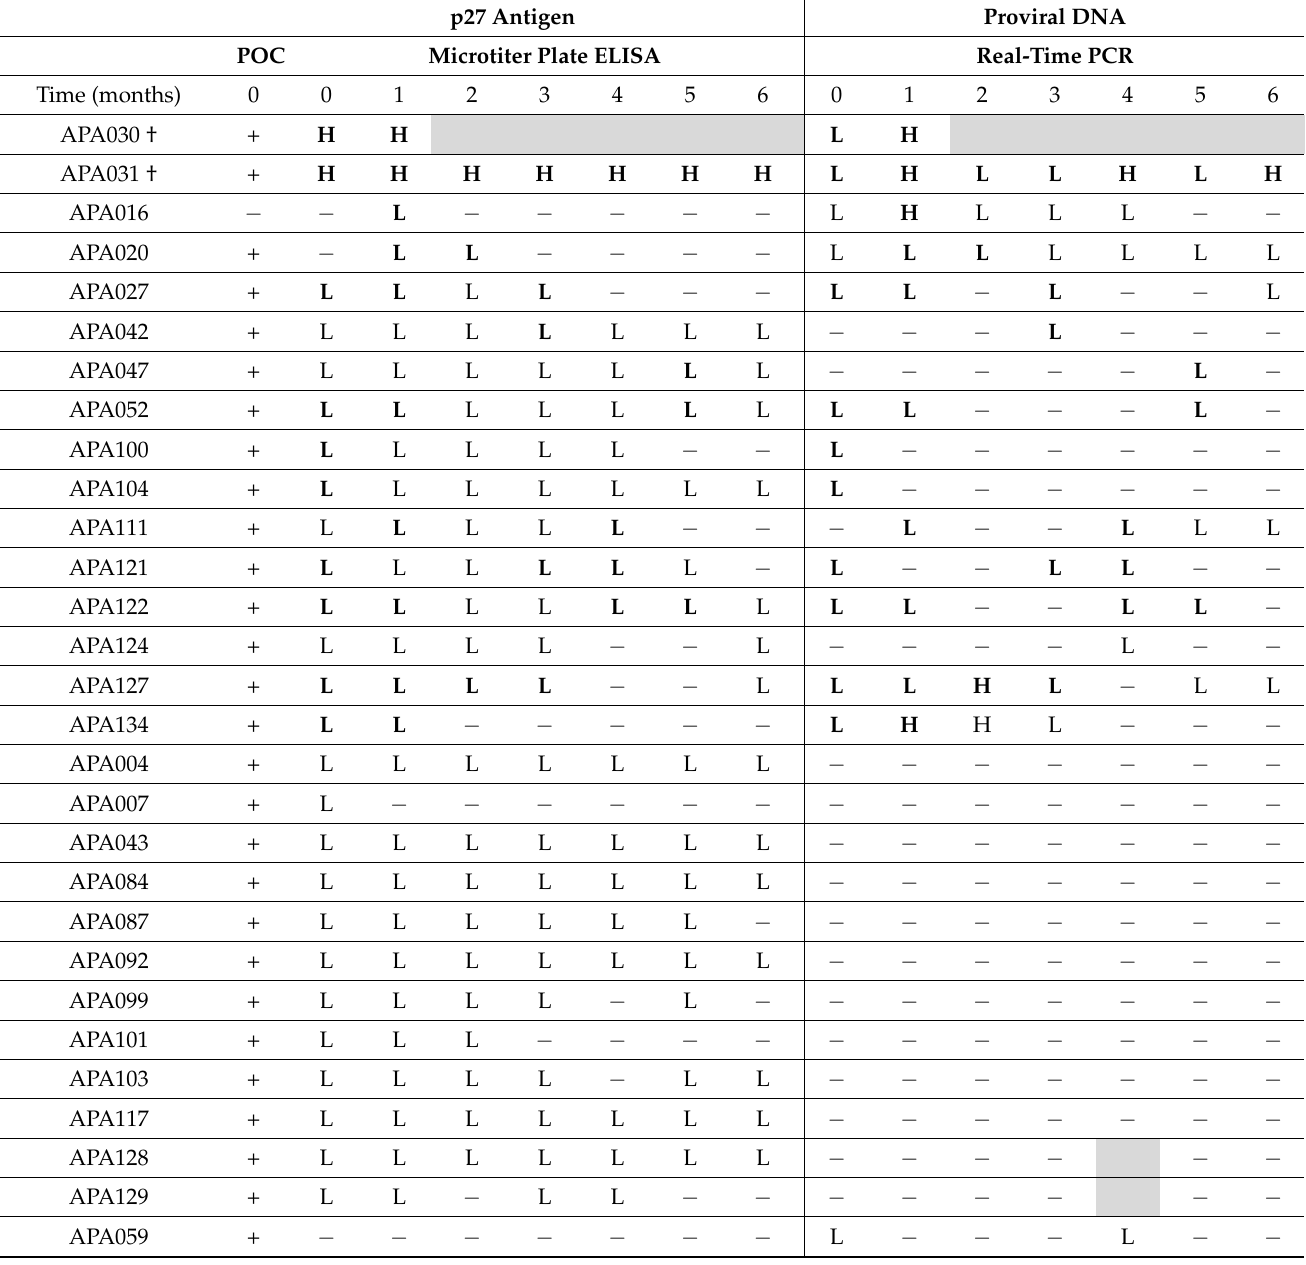
Table 4. Longitudinal test results for the 29 FeLV-positive cats classified as low positive based upon the ROC cutoff values applied to the test results obtained in the laboratory at the time of enrollment. Time points with concordant, qualitative positive results between p27 antigen and proviral DNA are shown in bold. Grey boxes indicate missing samples. (+, positive; − , negative; L, low positive; H, high positive; †,